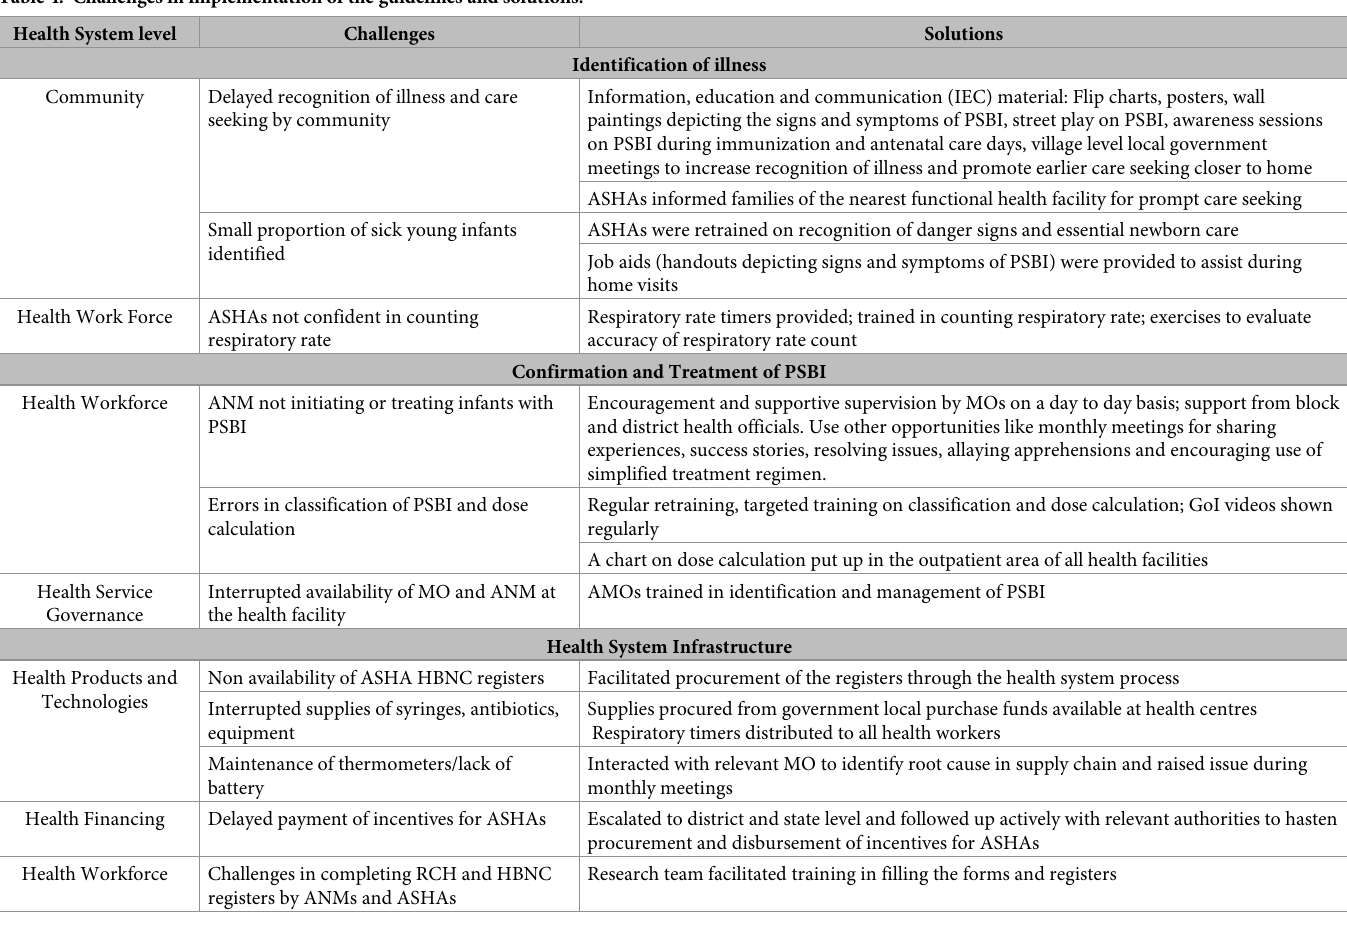
Table 4. Challenges in implementation of the guidelines and